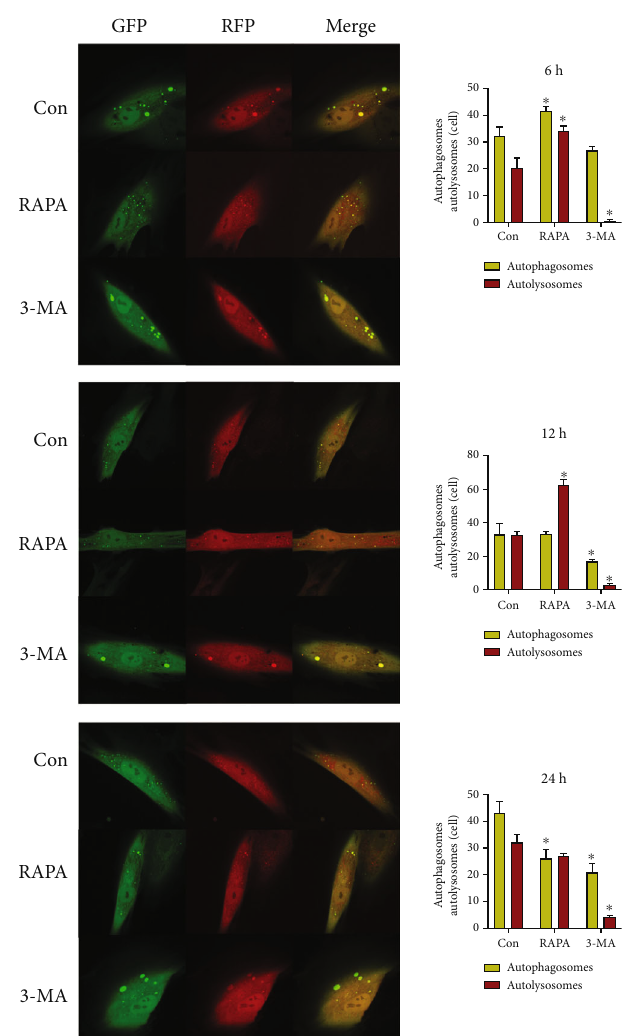
Figure 11: The detection of autophagy fl ux after drug regulation. ∗ P < 0 : 05 . GFP: green fl uorescent protein; RFP: red fl uorescent protein; RAPA: rapamycin; 3-MA: 3-methyladenine; Con: